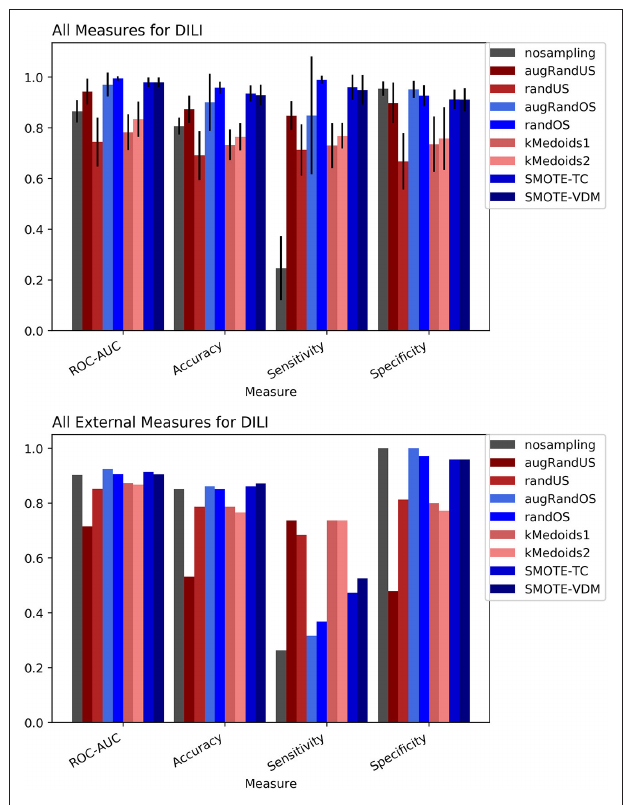
FIGURE 4 | Performance measures for cross-validation and external validation for DILI model based on Random Forest Classifier and MACCS fingerprints.